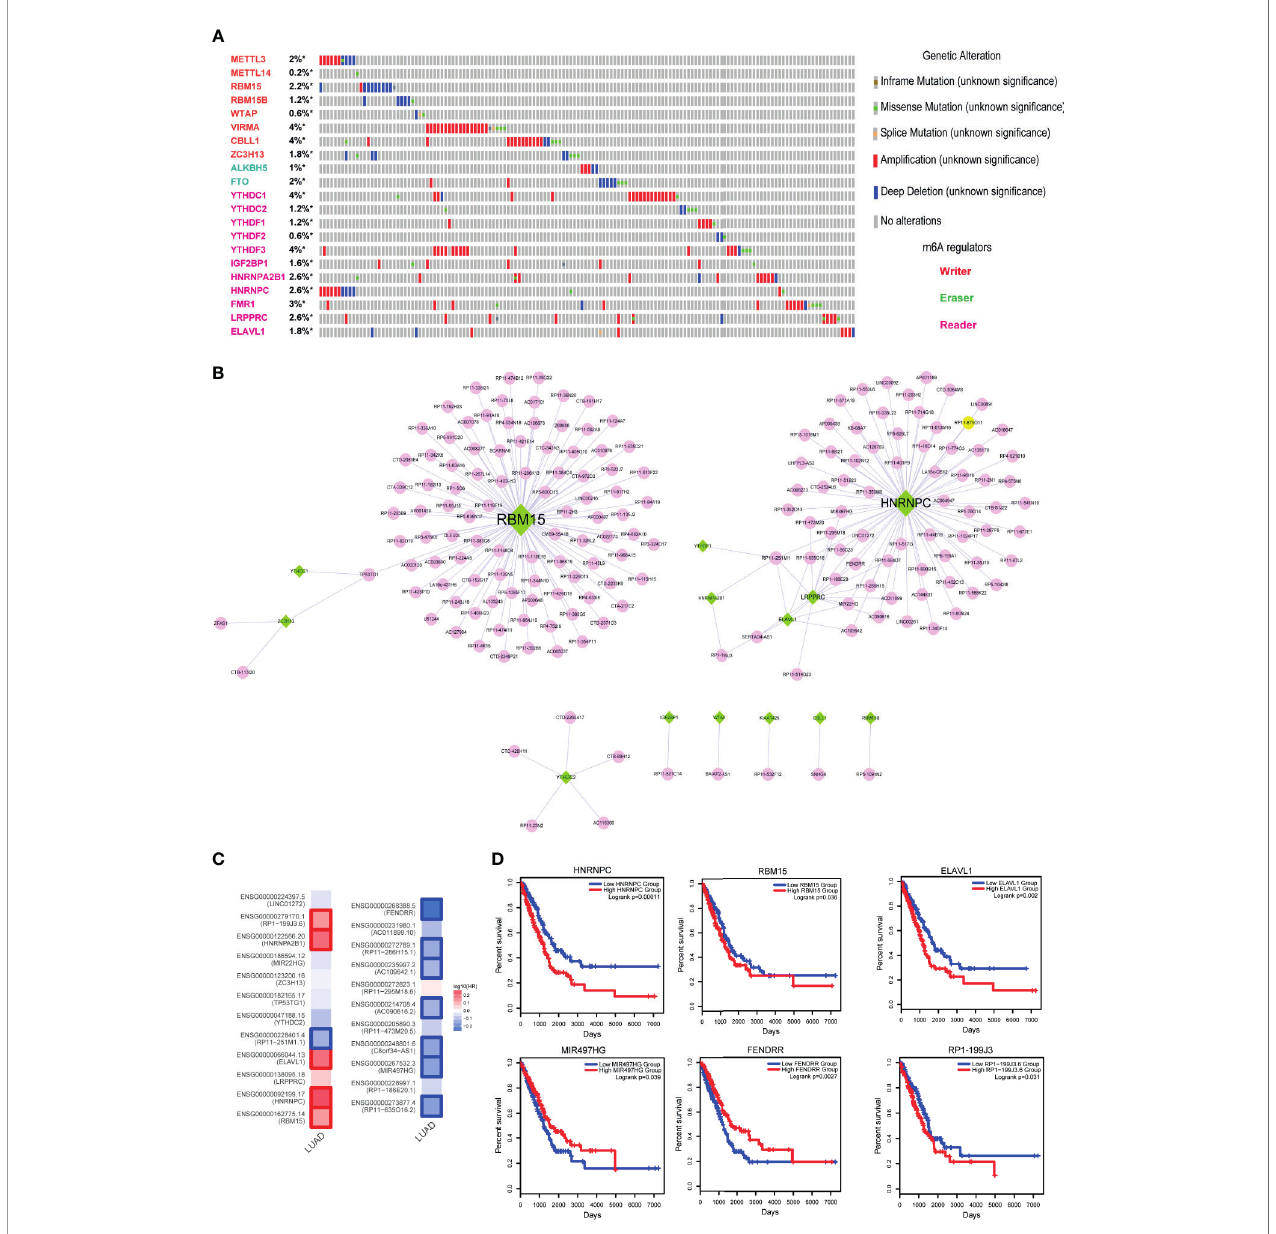
FIGURE 6 | Identi fi cation of m6A regulator-lncRNA pairs in LUAD. (A) Genetic alteration information of m6A regulators in LUAD. (B) High-correlated m6A regulator- lncRNA pairs. Green nodes represent m6A regulators, and pink nodes represent lncRNAs. (C) Hazard ratios of 23 key genes of the lncRNA-m6A regulator network. (D) The Kaplan-Meier survival curves of key lncRNAs and m6A regulators. *represents genes were selected in the